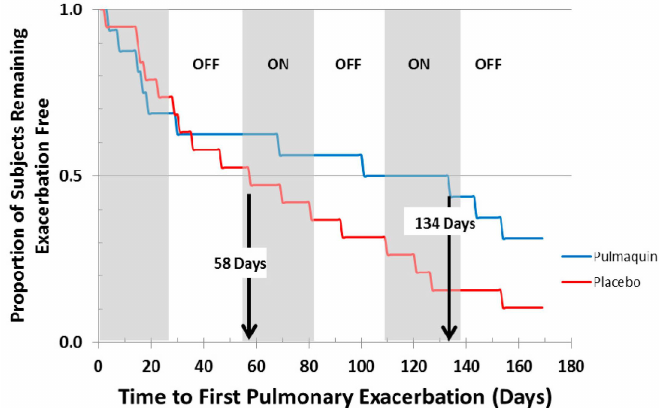
Figure 14. Kaplan–Meier curve showing the time to first pulmonary exacerbation for Pulmaquin and Placebo groups over the 3 treatment cycles (28 days on followed by 28 days off) in the modified intention to treat (mITT) population. Reprinted with permission from [21]. Copyright 2013 BMJ.